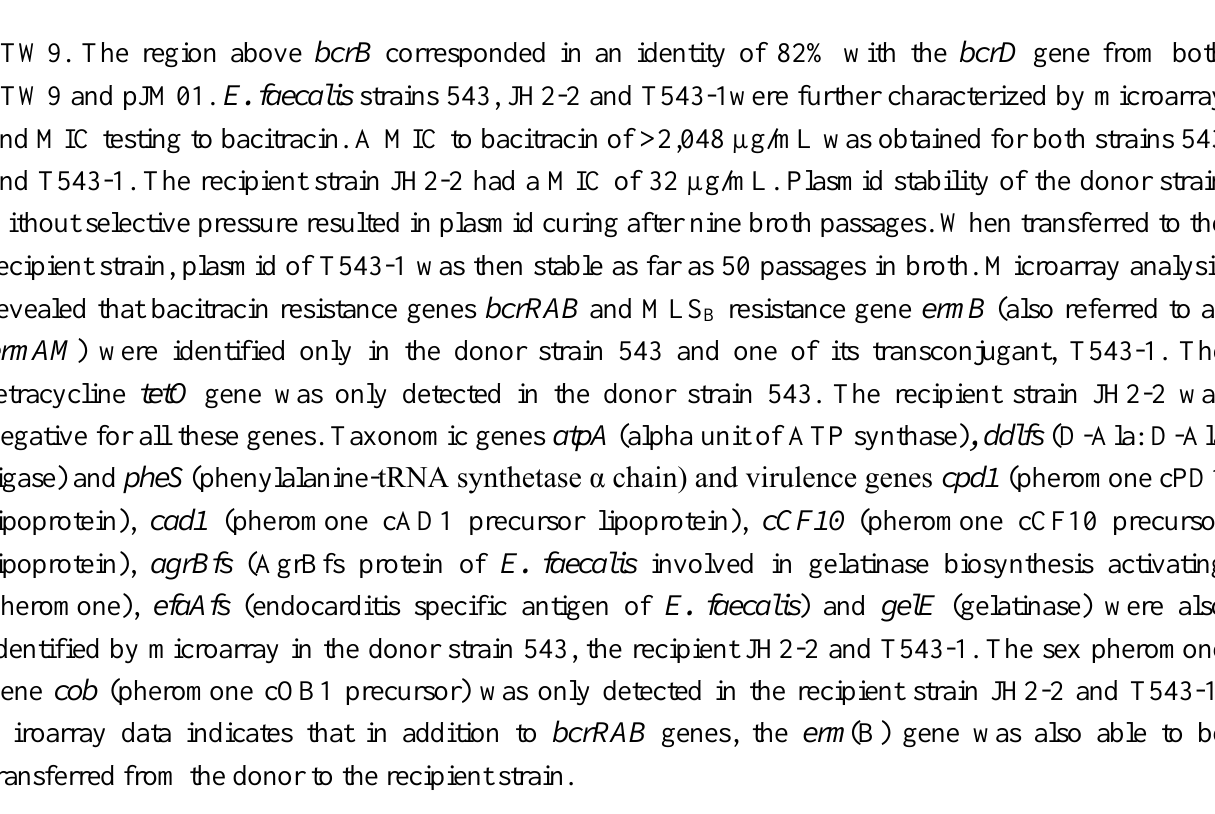
Figure 1. PFGE and hybridization of strains E. faecalis 543 and